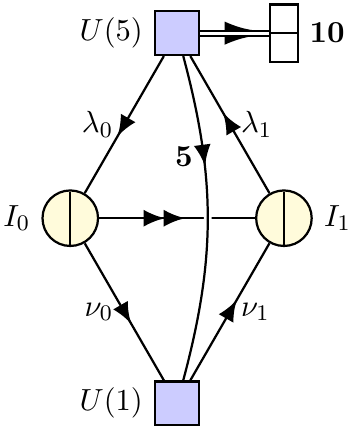
Figure 4 . The theory obtained after orientifolding the theory in (cid:12)gure 2. The quiver nodes I i have symplectic gauge factors, formally given by USp (0) in the absence of probe